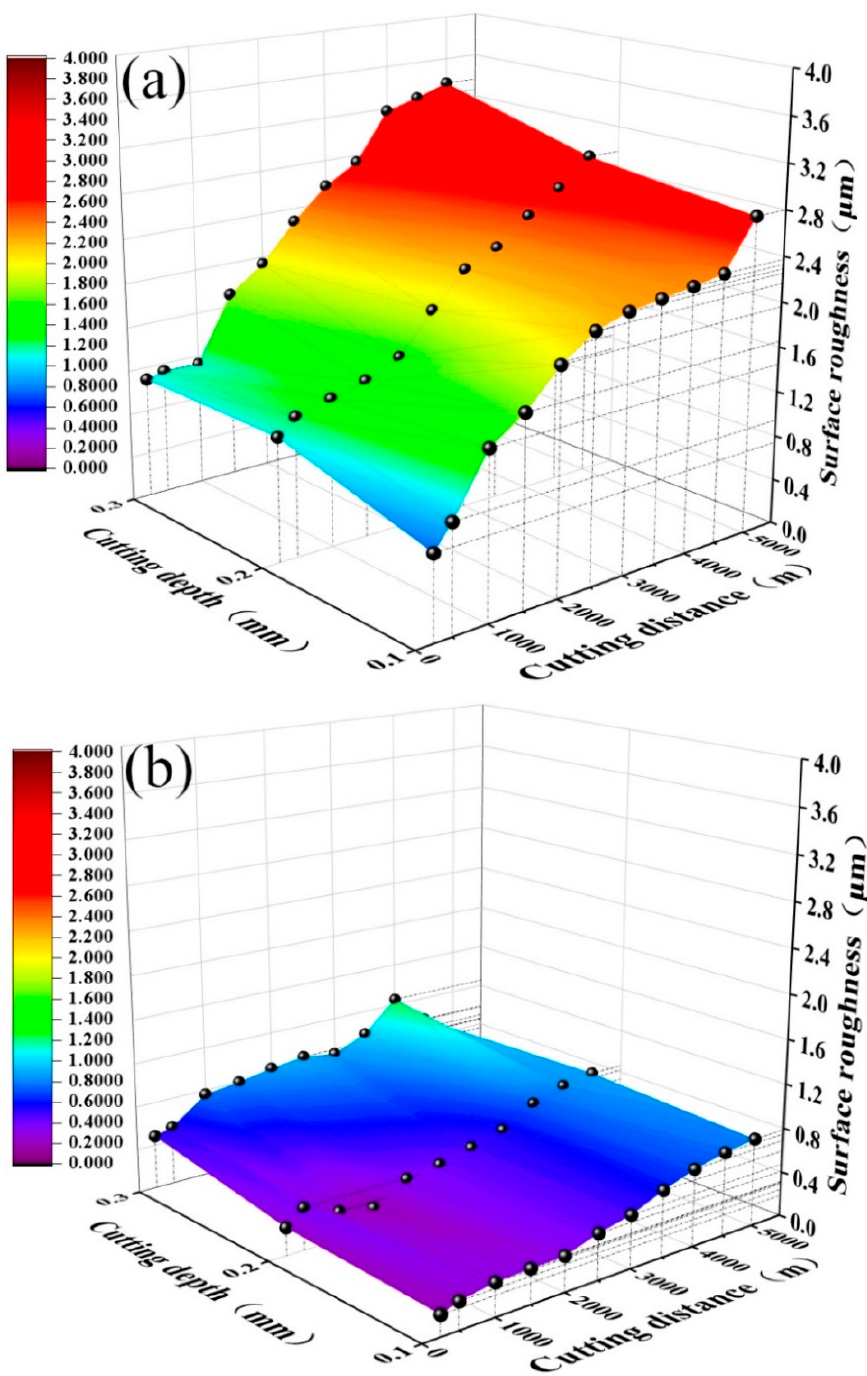
Figure 9. Workpiece surface roughness R a against cutting distance S at different cutting depths: ( a )